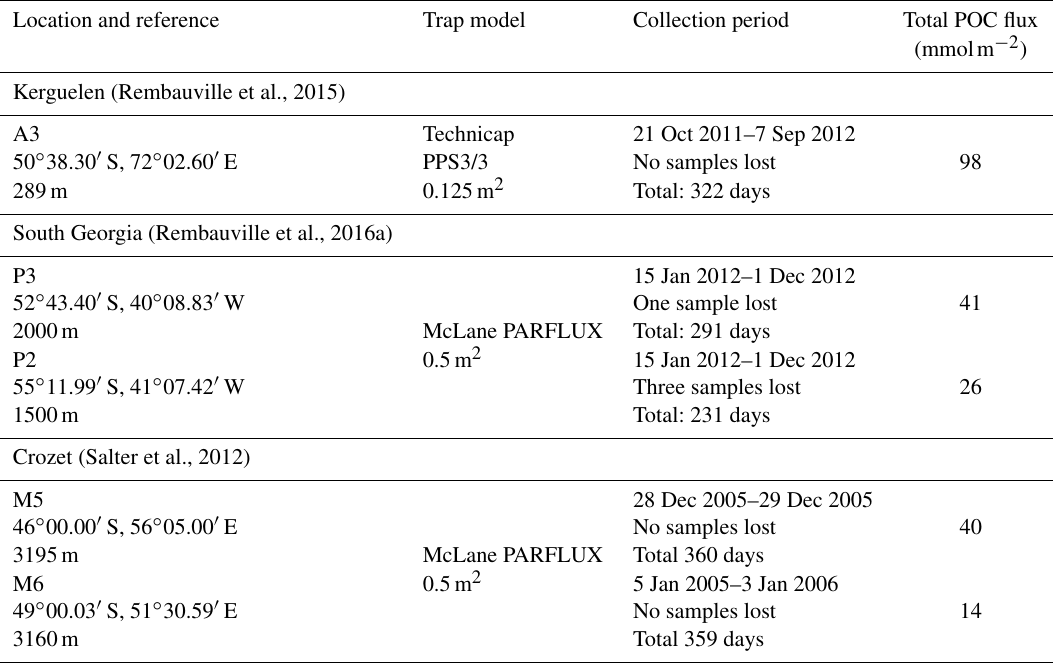
Table 1. Information on sediment trap deployments and fluxes of particulate organic carbon (POC) integrated over the deployment period. Location and reference Trap